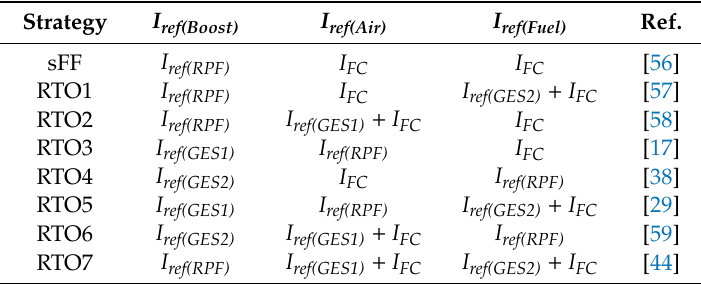
Table 1. Real-Time Optimization (RTO)